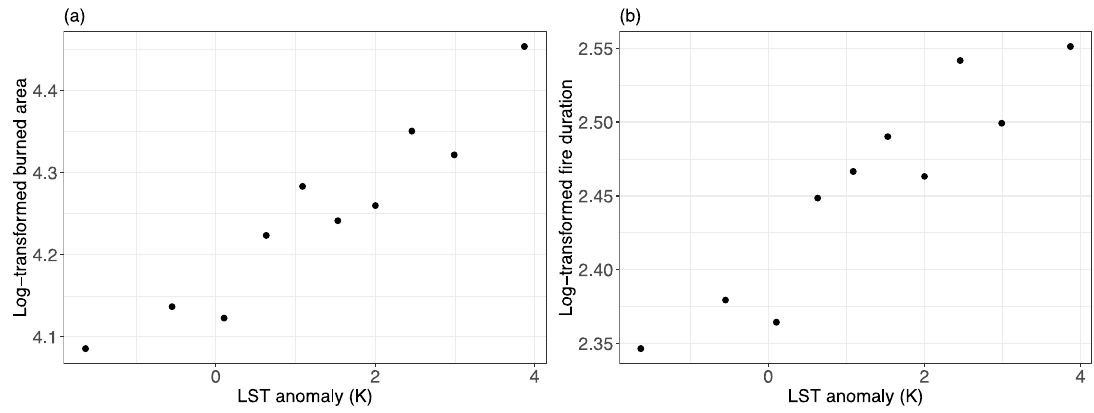
Figure 8. Variation of mean burned area ( a ) and mean fire duration ( b ) in ten deciles of land surface temperature anomaly. Table 3. Anderson-Darling distance values for all tested distributions.